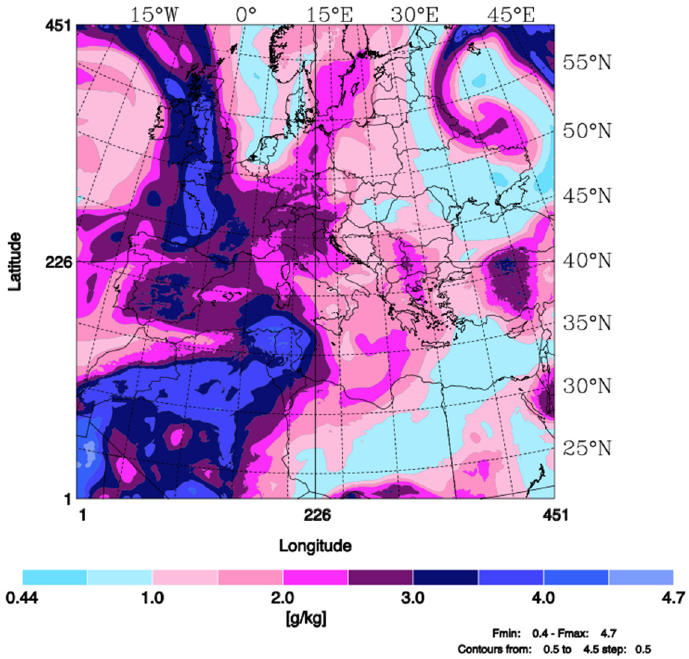
Figure 3. Water vapor mixing ratio averaged between 3 km and 8 km at 12:00 UTC on 15 July 2020.